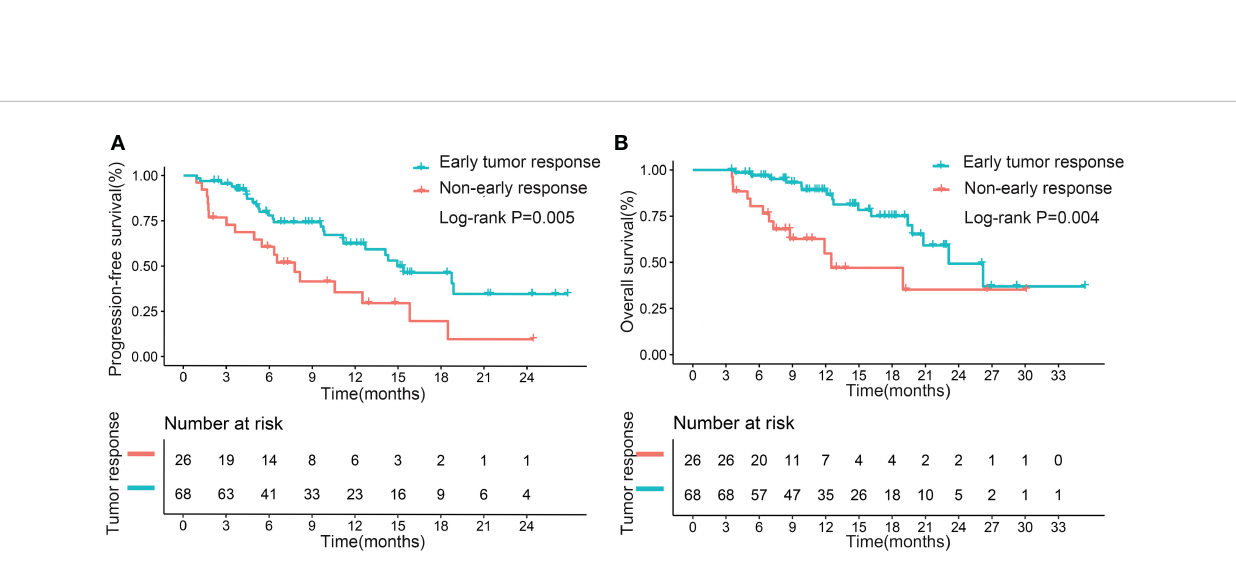
FIGURE 2 Kaplan – Meier curves for progression-free survival (A) and overall survival (B) , based on early tumor response in the entire